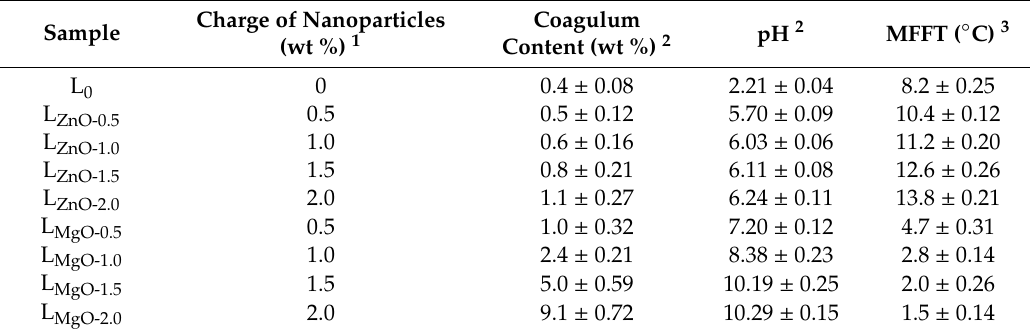
Table 2. Characteristics of self-crosslinking latex binders di ff ering in type and content of inorganic